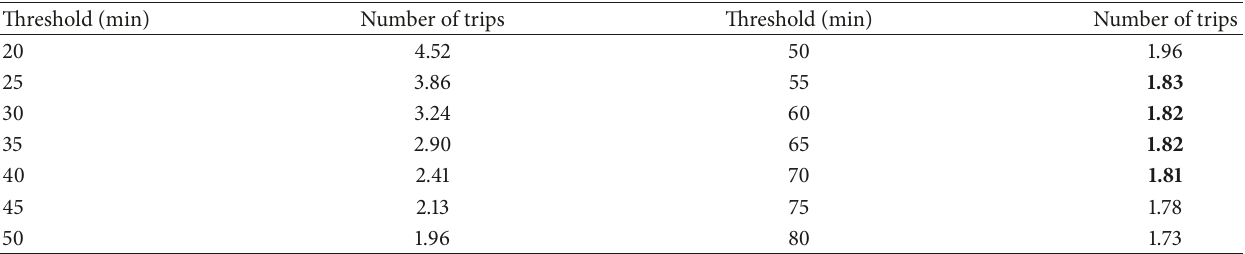
Table 4: The average number of trips for different